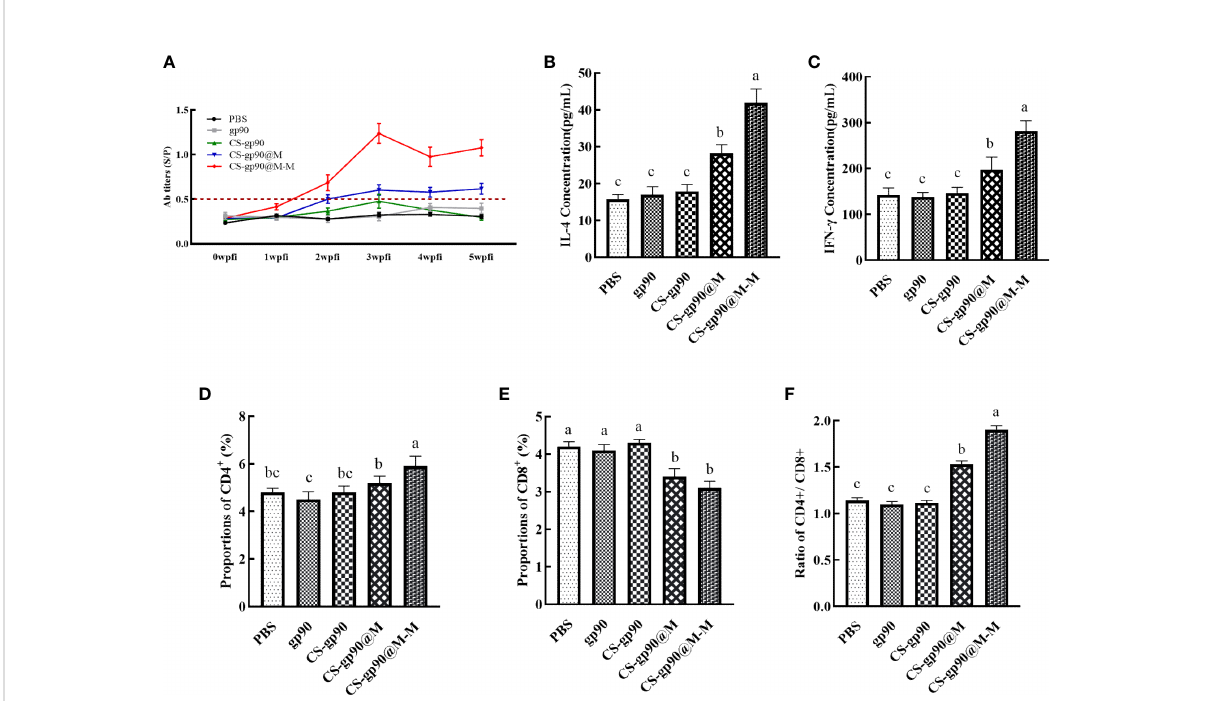
FIGURE 4 Effect of CS-gp90@M-M NPs on the antibody response, T lymphocyte phenotype, and cytokine production in chicks. Serum samples from chicks were collected on days 7, 14, 21, 28, and 35 for ELISA analysis after the fi rst immunization. REV-speci fi c IgG levels (A) were determined using ELISA. IL-4 (B) and IFN- g (C) levels in the serum of chicks were determined using ELISA. CD4+ (D) , CD8+ (E) , and the CD4+/CD8+ T cell ratio (F) in peripheral blood were analyzed using FACS. The different letters (a – c) designated as statistically signi fi cant differences ( P<0.05